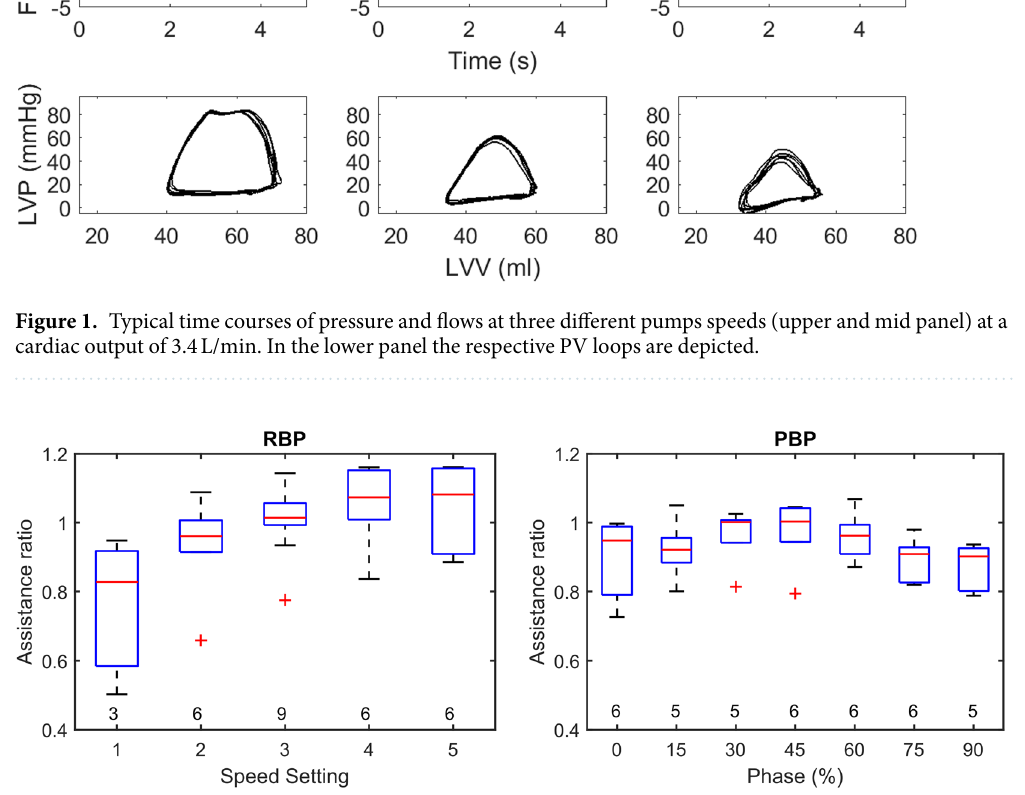
Figure 2. Box plots of assistance ratios recorded during RBP and PBP support. The sample size of each measurement is noted below each of the